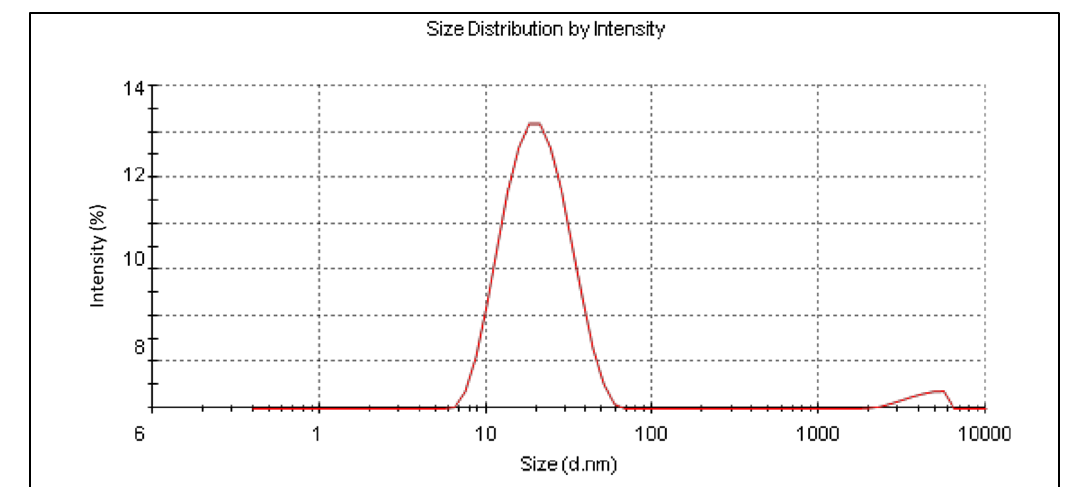
Figure 3. Size distribution of optimized LRX-loaded NE formulation.